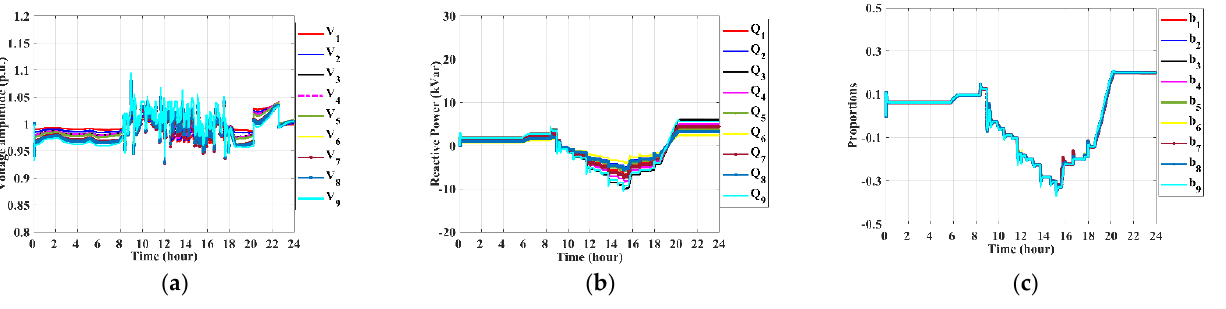
Figure 7. Node voltage fluctuation with OLTC and PV reactive power: ( a ) Nodal voltage fluctuation; ( b ) PV reactive power output; ( c ) proportions of reactive power. ( b ) PV reactive power output; ( c ) proportions of reactive